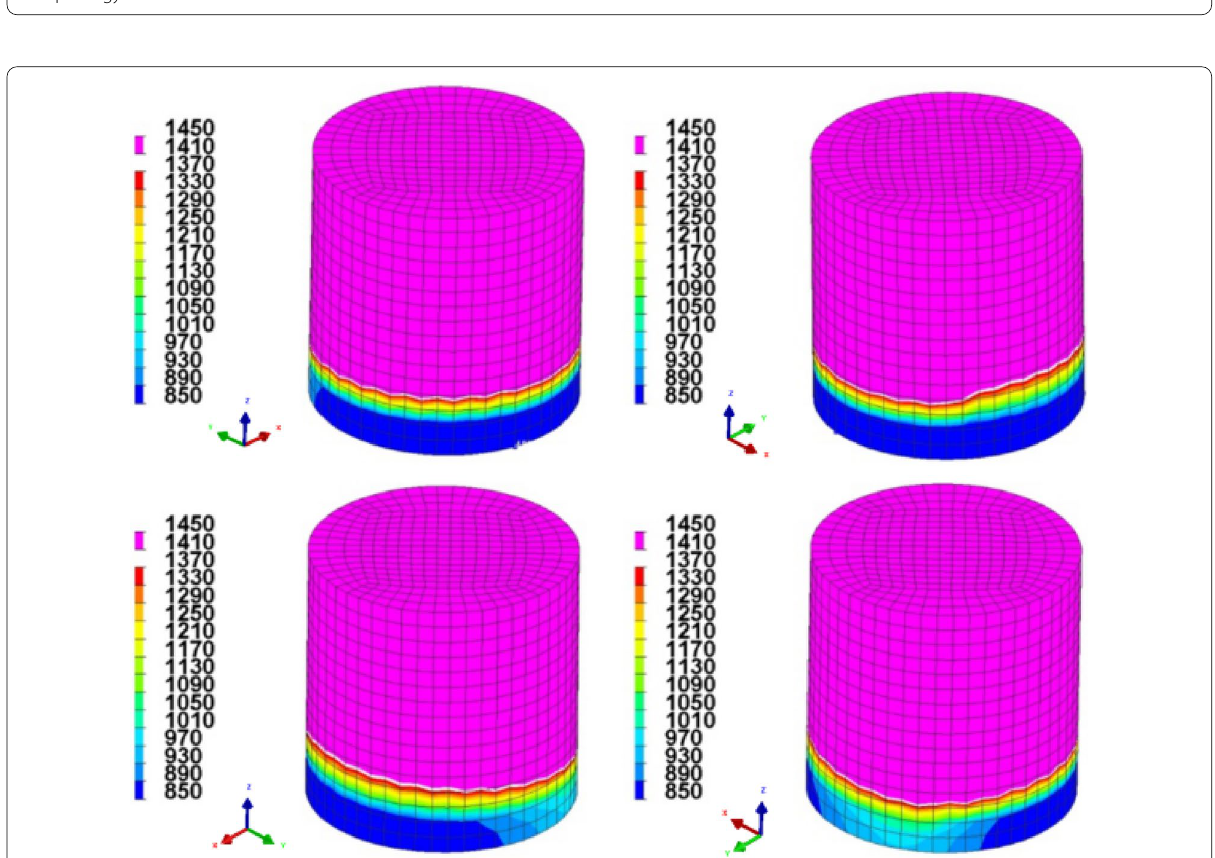
Figure 12 Temperature field distribution cloud map under the welding condition of